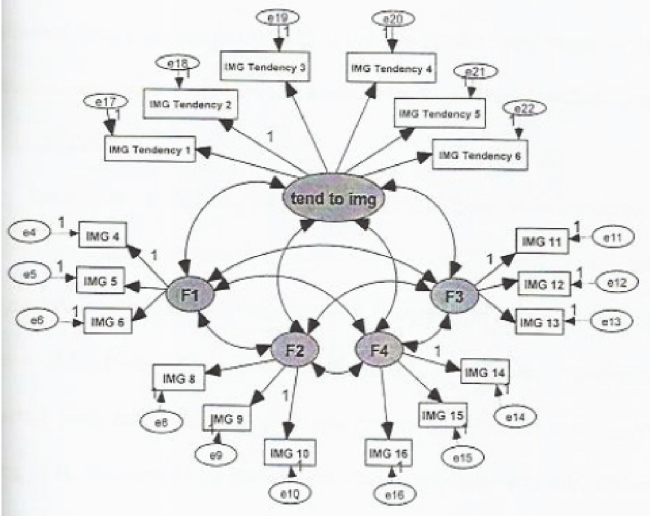
<Figure 5> Imagination Scale’s Construct Validity Testing: Imagination Types and Tendency to